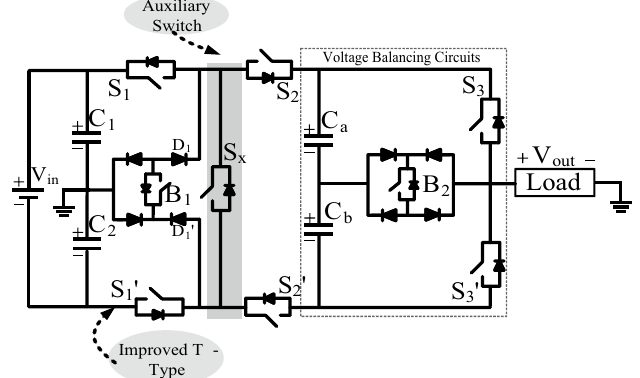
Figure 1. Proposed single-phase basic unit for 9L operation.